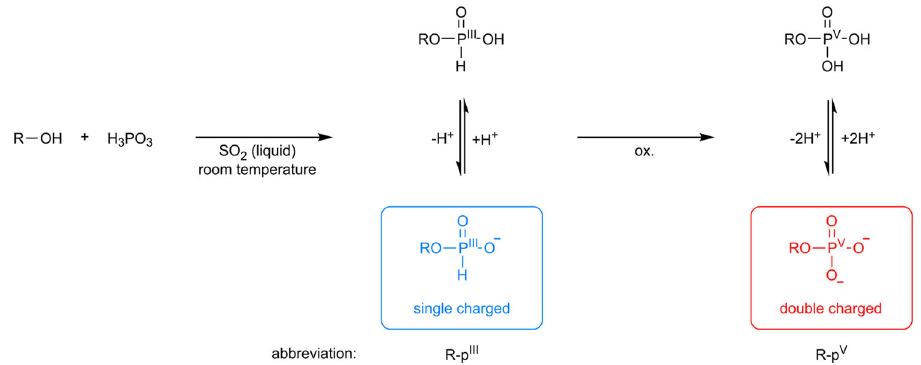
Fig. 1 Conceptualization of the phosphorylation with H 3 PO 3 in liquid SO 2 . Condensation of a substrate with H 3 PO 3 in liquid SO 2 at room temperature yields the corresponding H-phosphonate. Under the same reaction conditions the reaction medium oxidizes the H-phosphonate intermediate to the